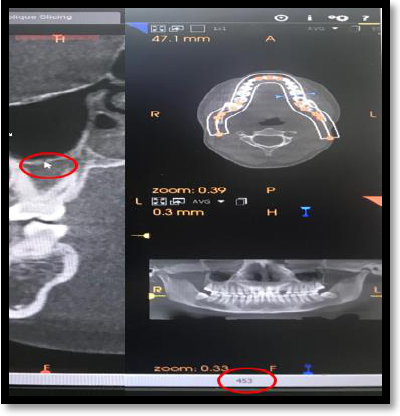
Figure 3: Measurement of density